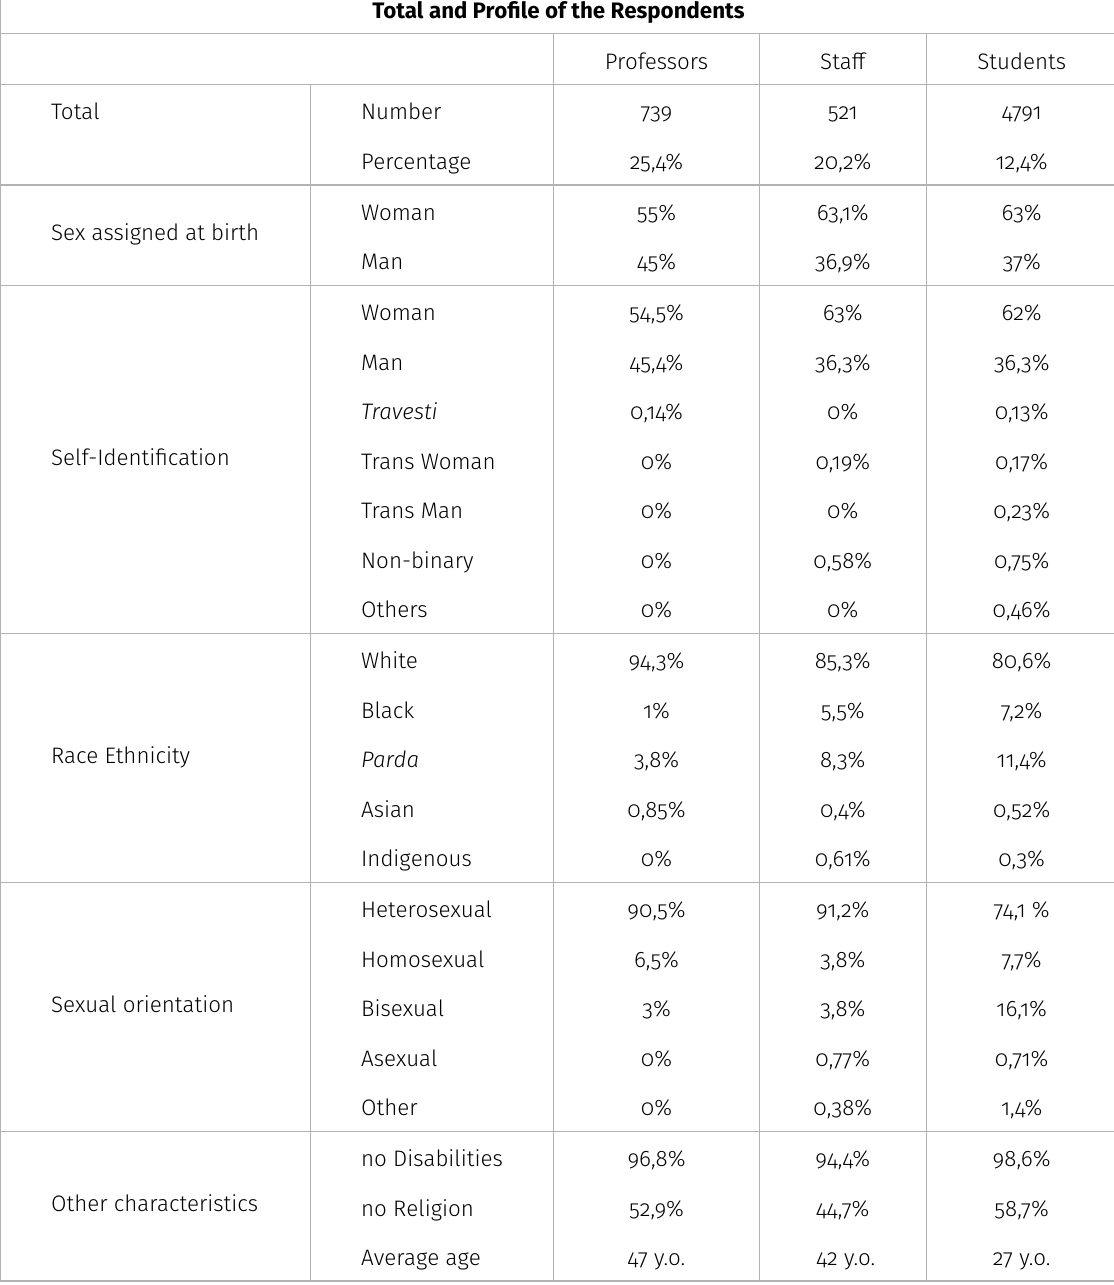
Table I. The first line shows the total number of questionnaire respondents. The second one exhibits the percentage of the total number of teachers, staff, and students at UFRGS. The other lines present the profile of the respondents in the different characteristics asked in the